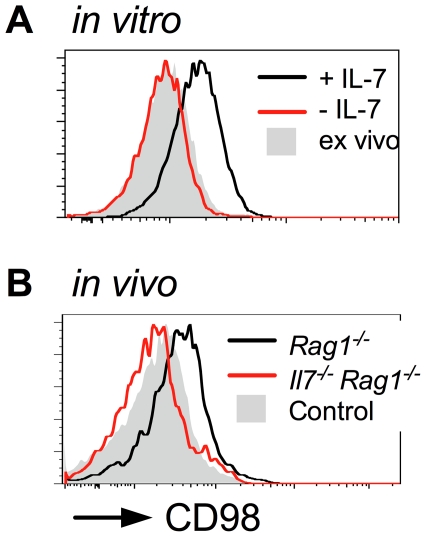
IL-7 regulates CD98 expression levels in vitro and in vivo.CD8+ T cells from C57Bl6/J mice were either cultured in vitro in the presence or absence of IL-7 for 24 h, or transferred to either Rag1
−/− or Il7
−/−
Rag1
−/− hosts. Upper histograms show CD98 expression by CD44loCD8+ cells cultured for 24 h either alone (red line) or in the presence of 50 ng/ml IL-7 (black line) as compared with ex vivo control CD44loCD8+ T cells (grey fill). Lower histograms show CD98 expression in CD44loCD8+ cells transferred to Rag1−/− (black line) or Il7−/− Rag1−/− hosts (red line) for 3 days, as compared with ex vivo control CD44loCD8+ T cells (grey fill). Results are representative of three independent experiments.